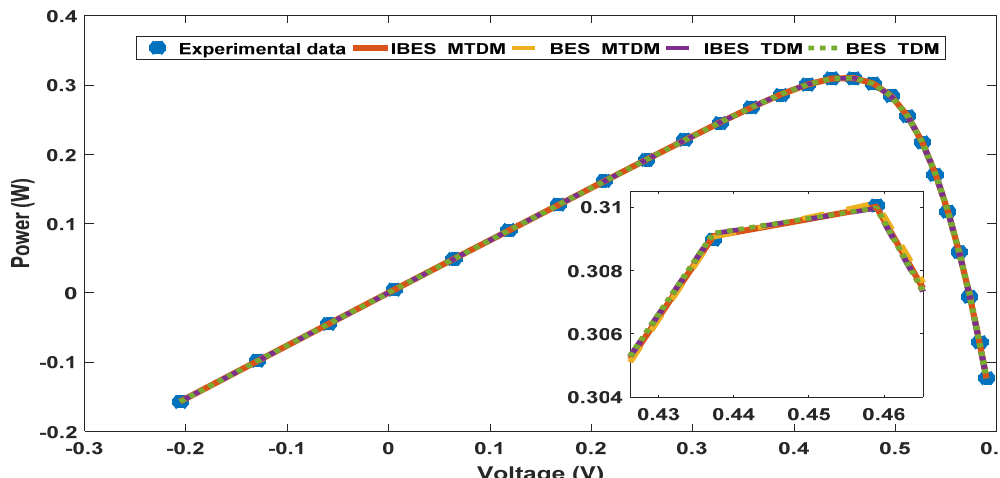
Figure 19. Power–voltage curve for the experimental data and for the MTDM and TDM currents estimated by the IBES and BES.